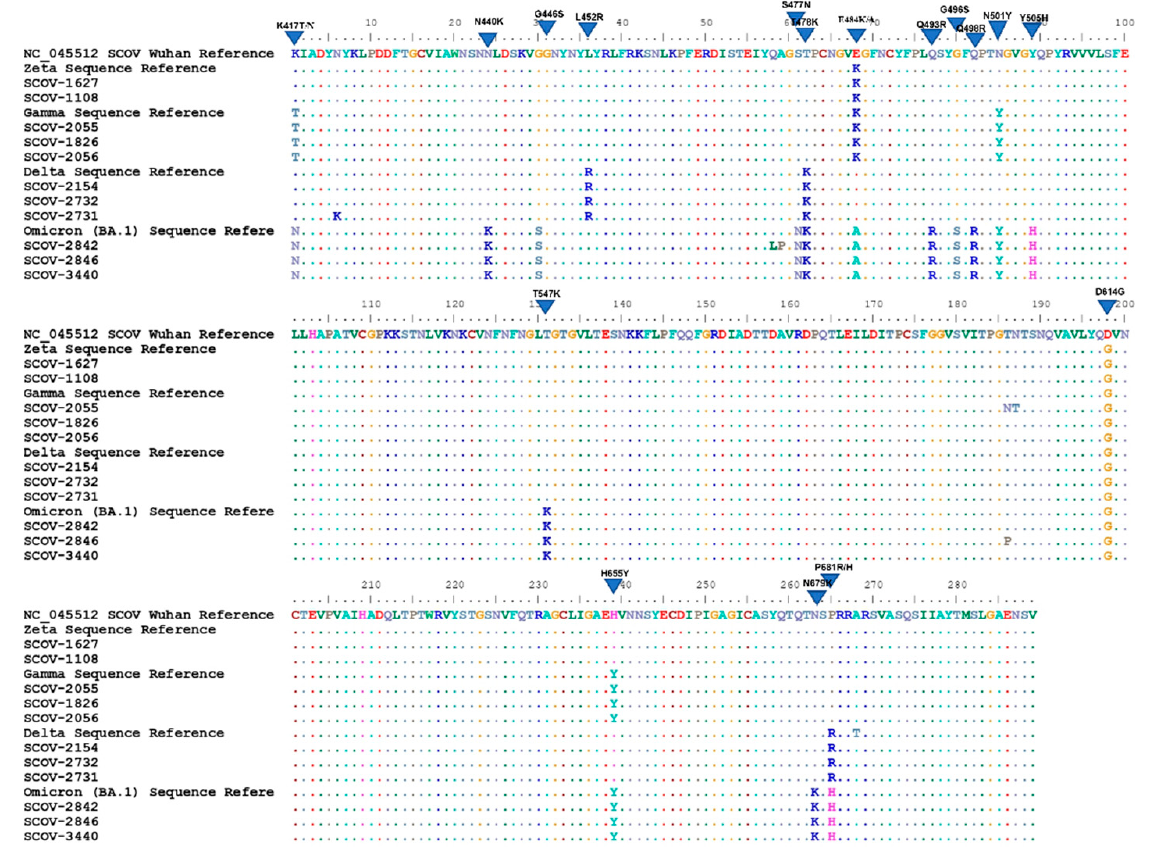
Figure 3. Alignment of the sequences with the representative of each variant and the reference generated in Wuhan. Protein sequences of some samples were aligned with templates for zeta (P.2), gamma (P.1), delta (B.1.617.2), and omicron (B.1.1.529). BA.1 plus the reference sequence generated